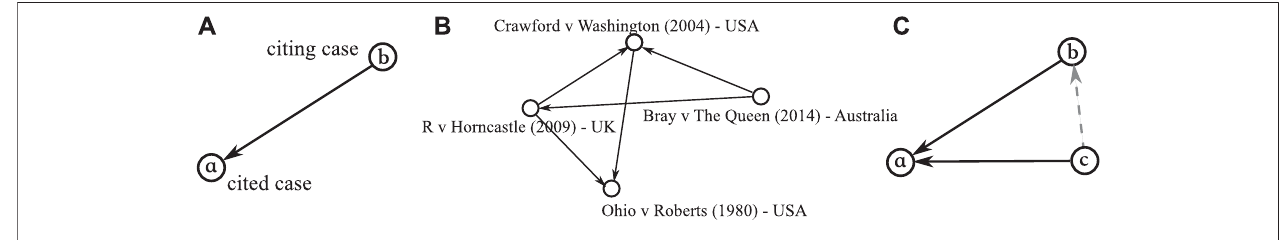
FIGURE 1 | The citation network. (A) Nodes a and b representing cases linked by a directed edge from citing to cited node. (B) The graph for four hearsay cases decided in Australia, the United Kingdom and the United States with cross-jurisdictional citation edges. (C) Triads between three citation nodes. It is considered a Triangle if the dotted edge c - b is included in the